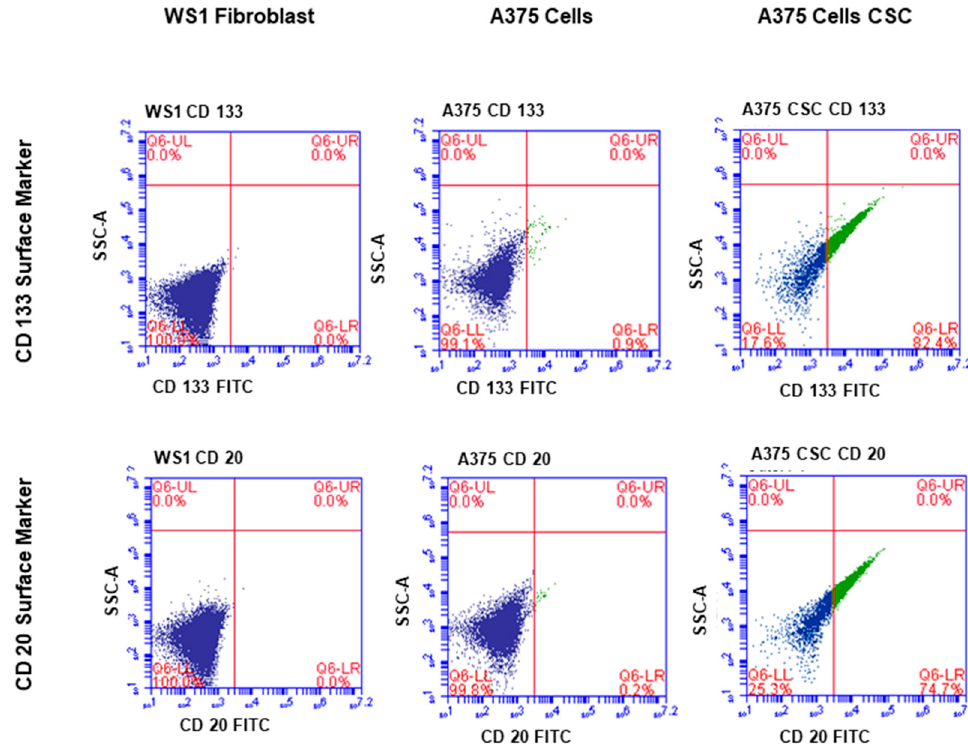
Figure 3. Flow cytometry analysis of the A375 subpopulation revealed antigenic surface markers in 82.4% of the cases, with 74.7% positive for CD133 and 74.7% positive for CD20. CD133 was found in 0.9% of the total A375 cell population, whereas CD20 was found in 0.2%. Both markers were absent in the WS1 fibroblast negative control.